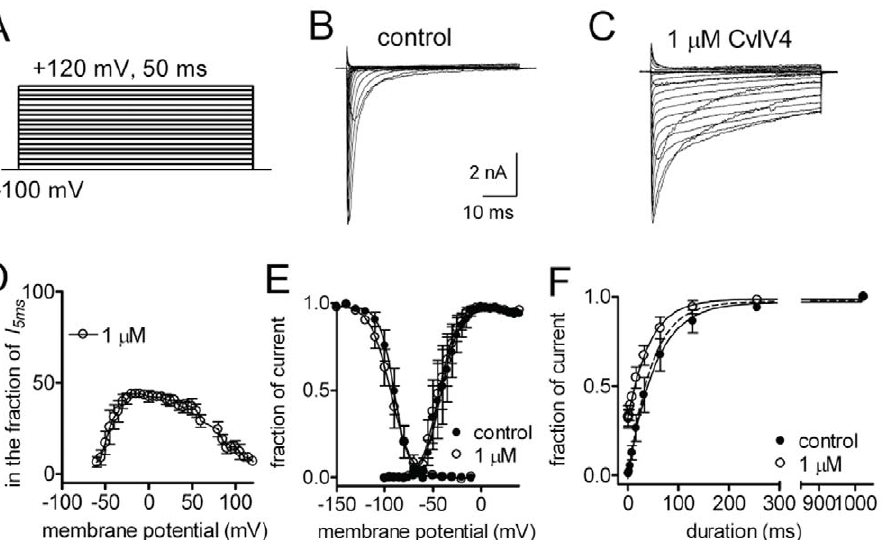
Figure 7. Effects of toxin CvIV4 on activation and inactivation of isoform Na v 1.7 expressed in Hek293 cells. A. Depolarizing pulses in 5- mV increments were used to elicit current from Na v 1.7 expressed in HEK cells before (B) and after (C) the application of 1 m M CvIV4. D. Effects of 1 m M toxin on the current-voltage relationship of Na v 1.7. Currents not inactivated at 5 ms in the presence of 1 m M toxin were plotted as the percentage increase in the fraction of current at 5 ms ( I 5 ms ). E. Effects of CvIV4 on steady-state activation and inactivation of Na v 1.7. When data points were fitted with a Boltzmann equation, the V1/2 values were 2 90.2 6 1.2 and 2 94.1 6 1.6 mV before (filled circles) and after (open circles) toxin treatment, respectively. F. Effect of CvIV4 on rate of recovery from inactivation at 2 100 mV. Cells held at 2 100 mV were given a depolarizing prepulse to 0 mV for 20-ms followed by a step back to 2 100 mV with increasing duration to allow channels to recover from inactivation, followed by a 20-ms test depolarization of 0 mV to activate those channels that had recovered from inactivation. Data points presented as a fraction of the maximum recovered current were fitted with single exponential function to estimate the time constant. The time constants were 58.7 6 15.4 and 48.2 6 15.3 ms before (filled circles) and after (open circles) toxin treatment,